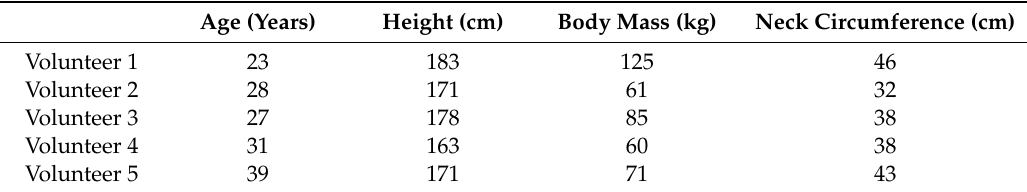
Table 1. Participants characteristics.